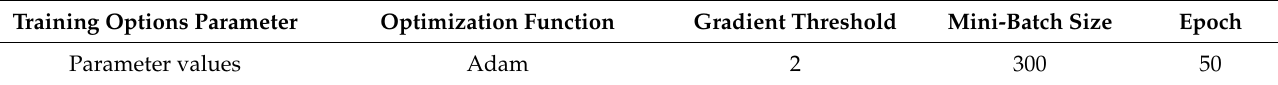
Table 2. Learning parameters of LSTM and Bi-LSTM.